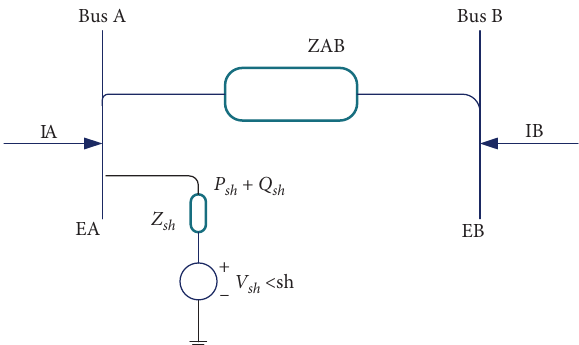
Figure 1: Modified equivalent circuit of STATCOM.